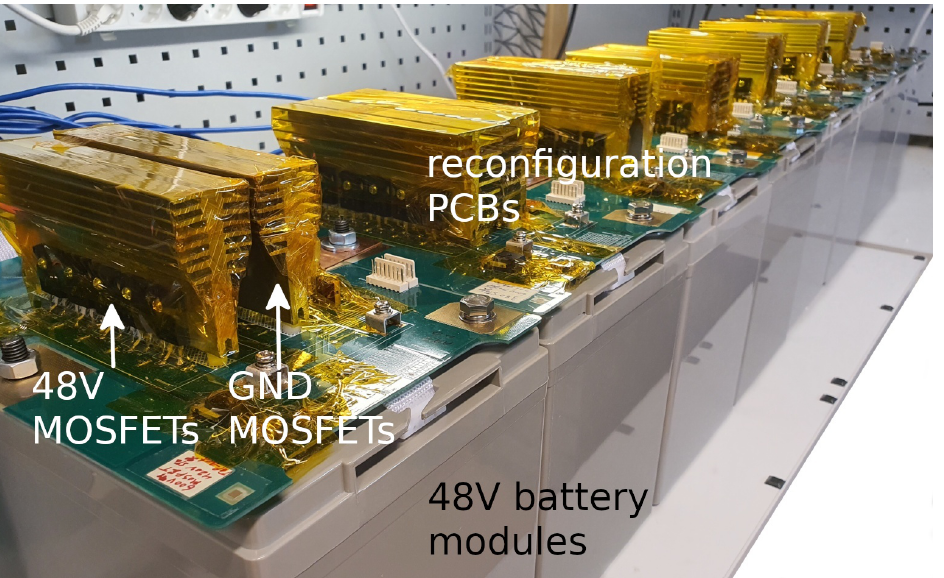
Figure 2. Part of designed prototype system with 8 lithium iron phosphate (LFP) battery modules with 48V/25Ah each and mounted reconfiguration printed circuit boards (PCBs). Battery configuration is controlled individually, while all module voltages and currents are monitored via an I2C